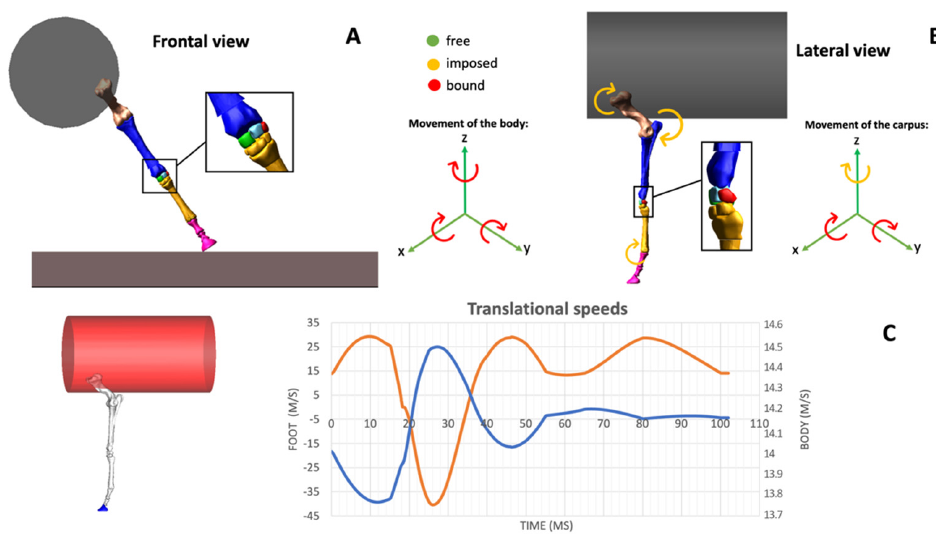
Figure 2. Introduction of kinematics data in the simplified equine carpal model ( A – C ). The body of the horse was simplified by using a cylindrical geometry (in grey) having a mass equal to the body weight. The frontal view of the forelimb which sustained the injury and the corresponding inclination with respect to the ground were introduced in the simulation and visualized during the stance phase of the stride ( A ). The animation is shown in Video S1. The position of the same limb during the stance phase of the stride was visualized in the lateral view ( B ). The translational speeds of the body of the horse and the foot, derived from data captured using inertial measurement units, are visualized in the corresponding graph ( C ). On the right part of the graph the speed of the body is scaled, on the left part the speed of the foot is scaled. The blue line joins the value of 0 at 18 ms from the beginning of the simulation; this corresponds to the moment when the foot hits the ground.